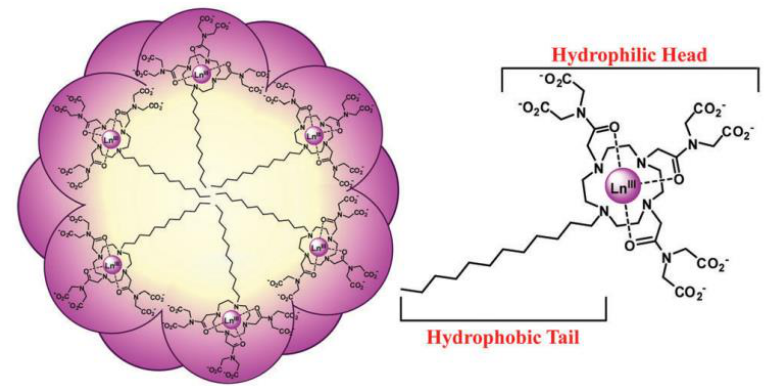
Figure 13. Schematic representation of the spherical micelles formed in aqueous solution with intertwined hydrophobic tails in the interior and hydrophilic head groups at the exterior. Ln(III) = Eu(III), Gd(III), or Lu(III). Reproduced from [182], with permission from RSC Publisher, 2016.